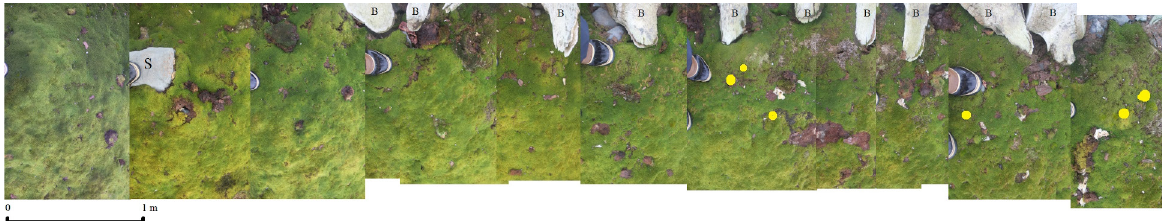
Figure 5. Photograph assembly showing the carpet at the western side (first sector) of the whale skeleton. Yellow dots are cushions of Syntrichia spp. B = vertebrae bones; S =